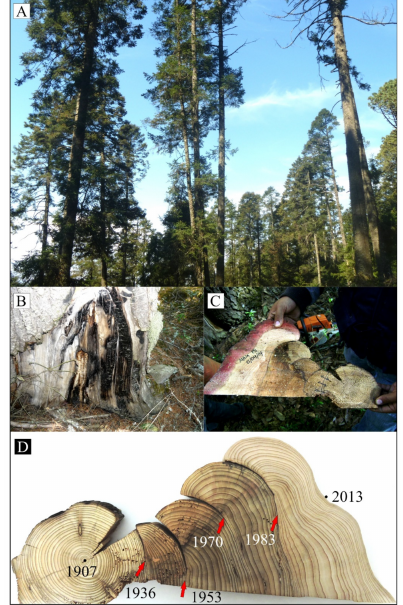
Figure 2. ( A ) Forest conditions within Abies religiosa forests in the Sierra Norte de Puebla, Mexico. ( B ) Base of a living tree with multiple visible fire scars. ( C ) Partial cross-section sampled from a living tree showing four fire scars. ( D ) Partial cross-section of a 107-years old Abies religiosa after it had been sanded and dated. The red arrows indicate fire-scars along with the calendar year of the fires (red and black numbers), as well as the pith and least recorded